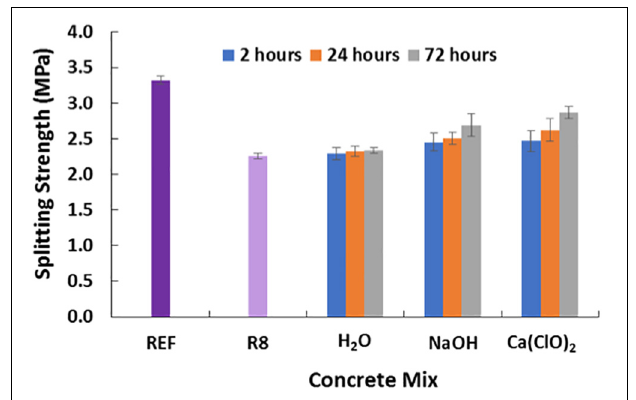
FIGURE 7 | Average 28-day splitting tensile strength of reference and rubberized concrete.